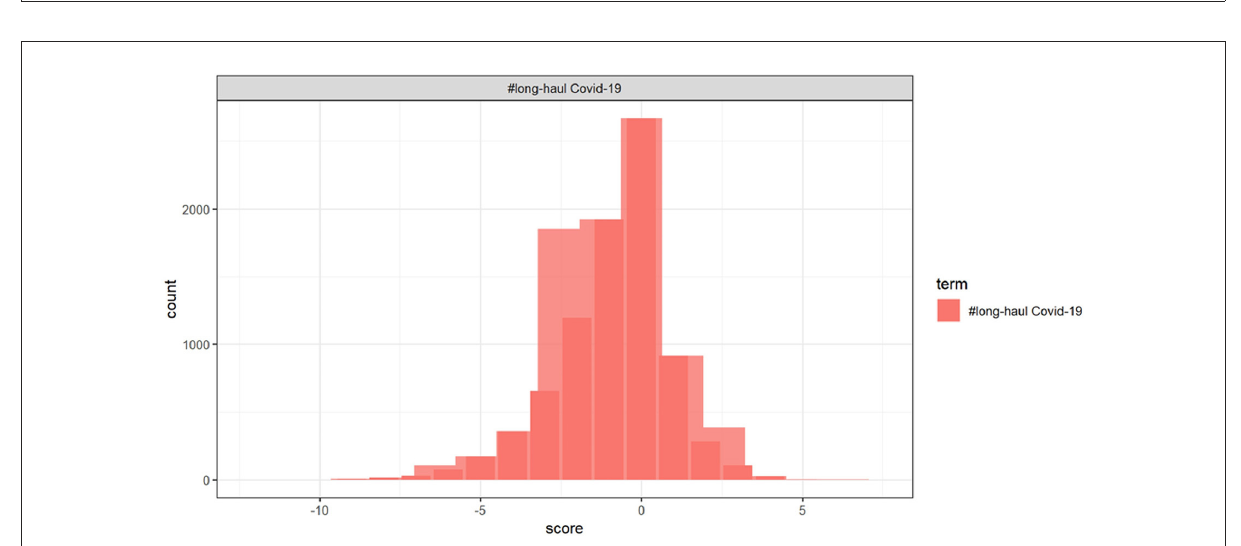
FIGURE13 The distribution of sentiment